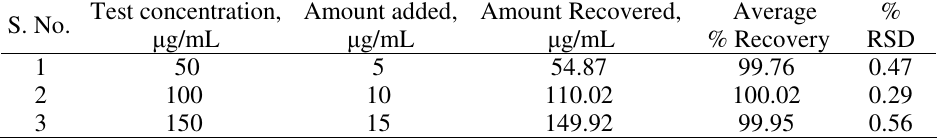
Table 3. Results of Accuracy (Recovery studies, n=3)